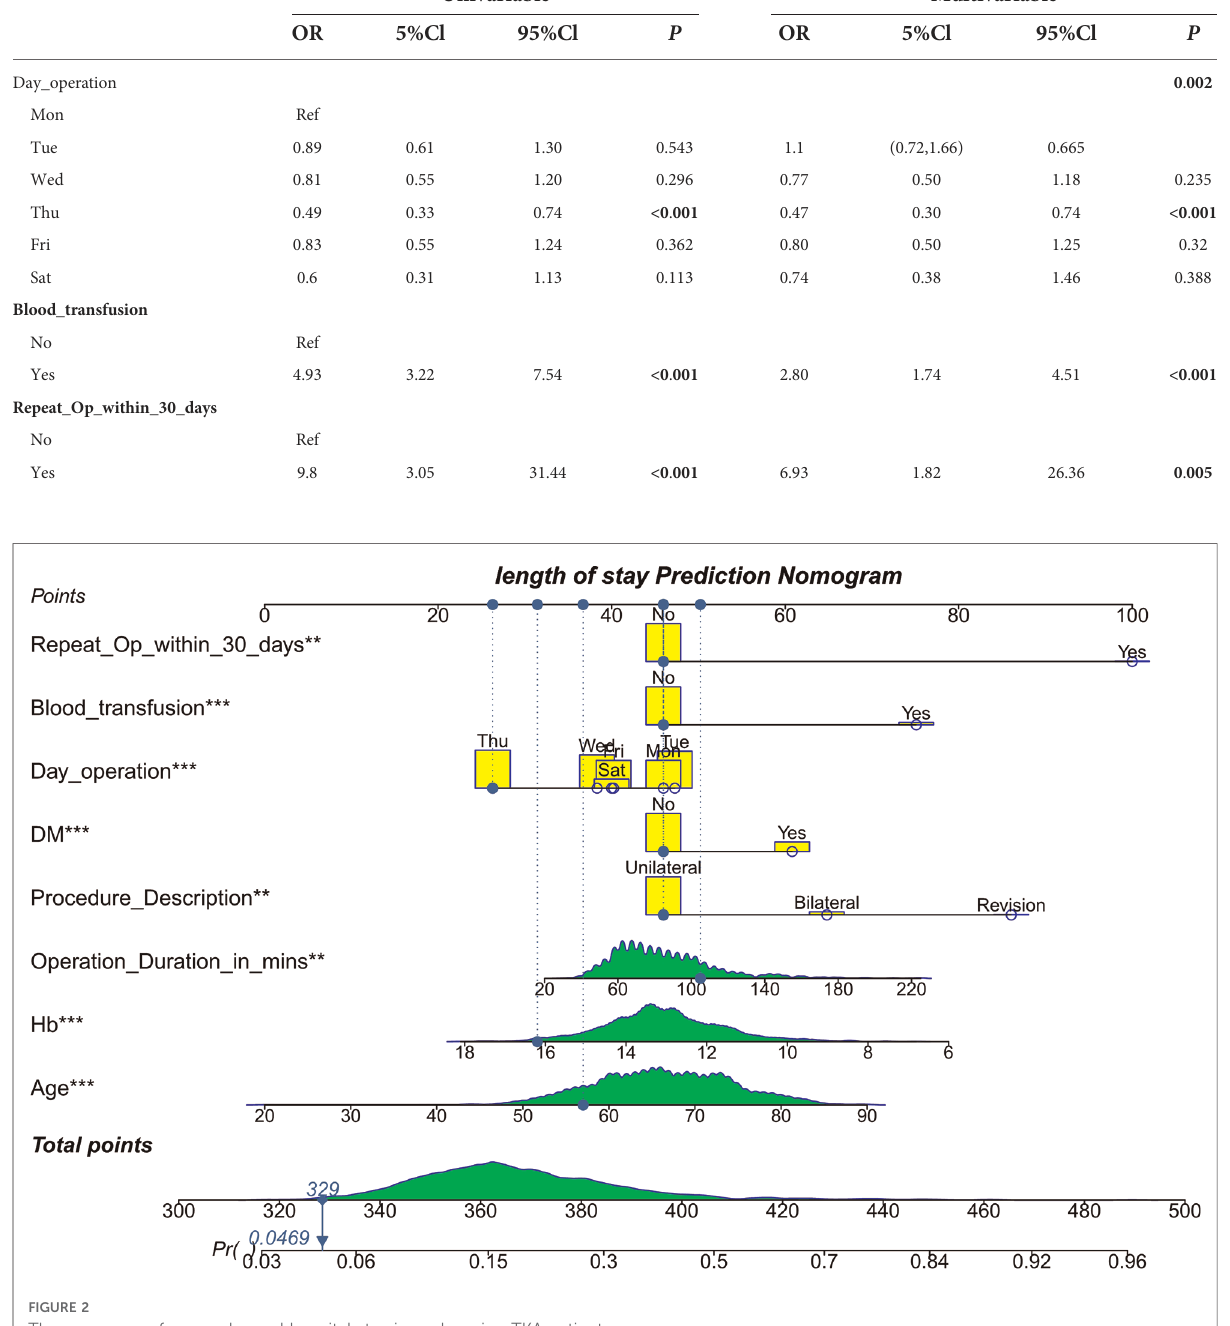
FIGURE 2 The nomogram for a prolonged hospital stay in undergoing TKA